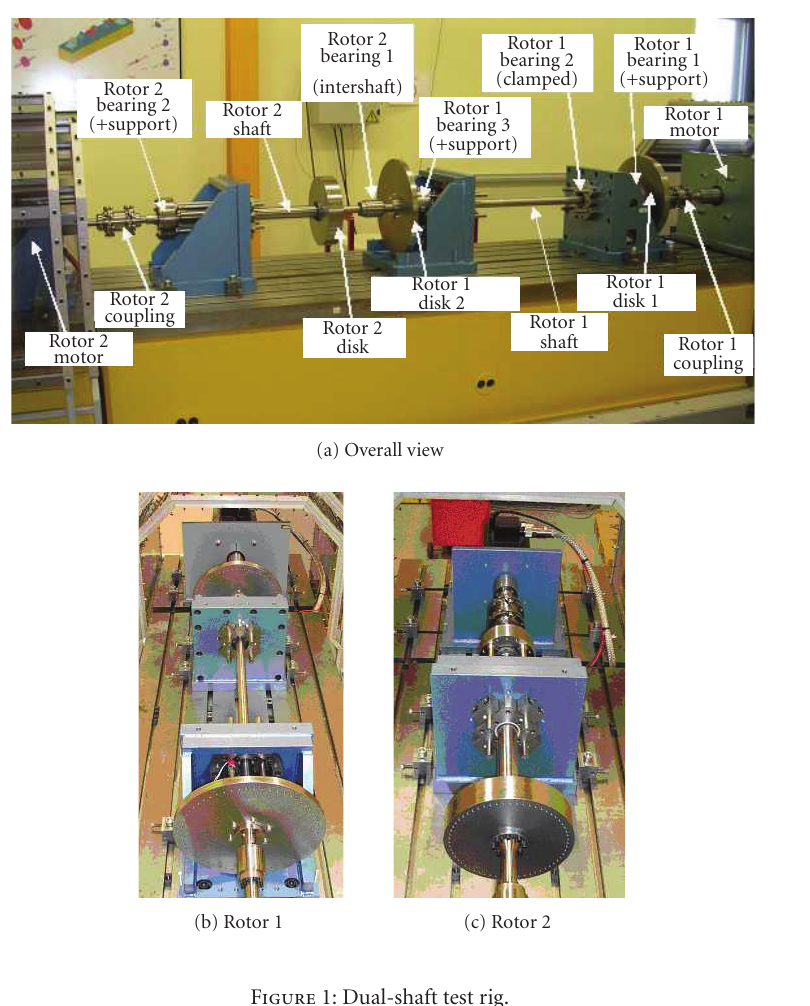
Figure 1: Dual-shaft test rig.